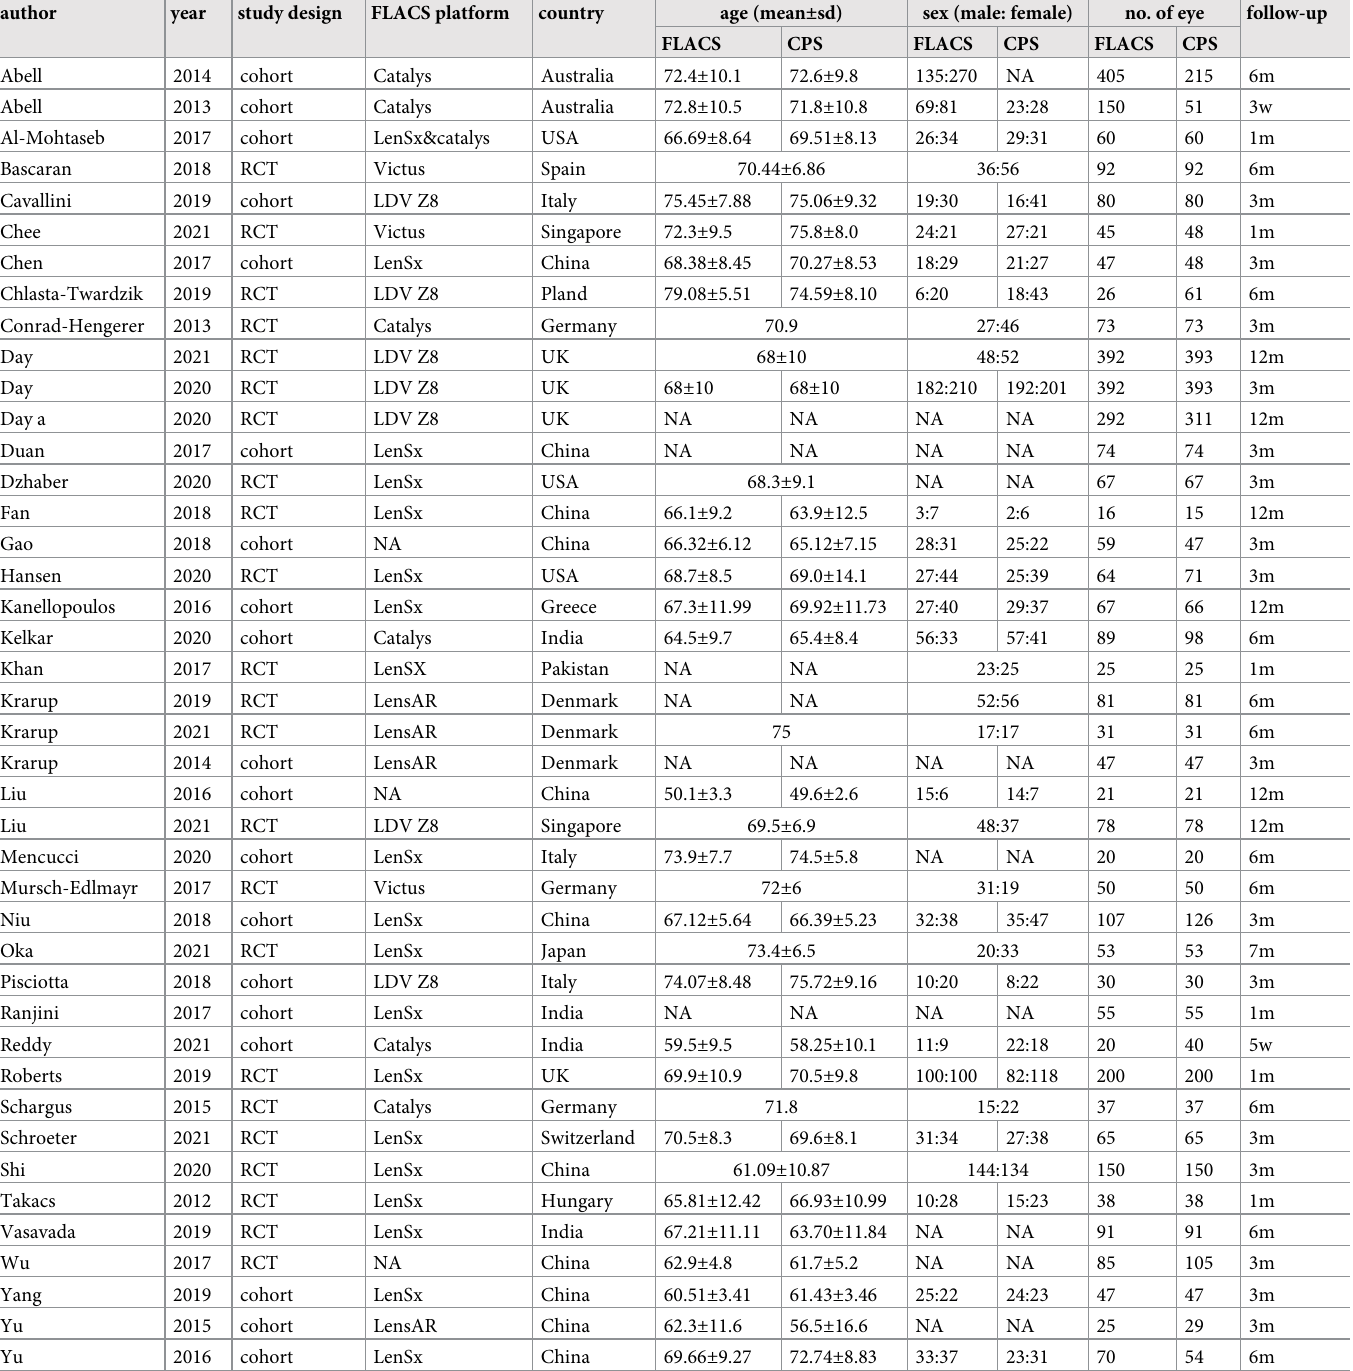
Table 1. Characteristics of the included